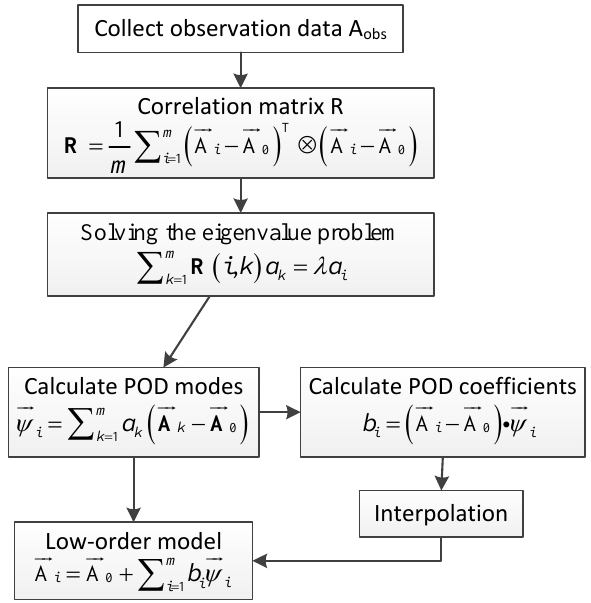
Figure 3. Schematic diagram of POD method for cross-interference coefficient